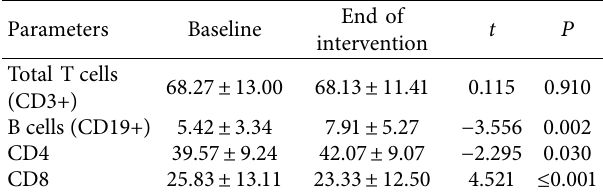
Table 3: Changes in serum immune function parameters after intervention.